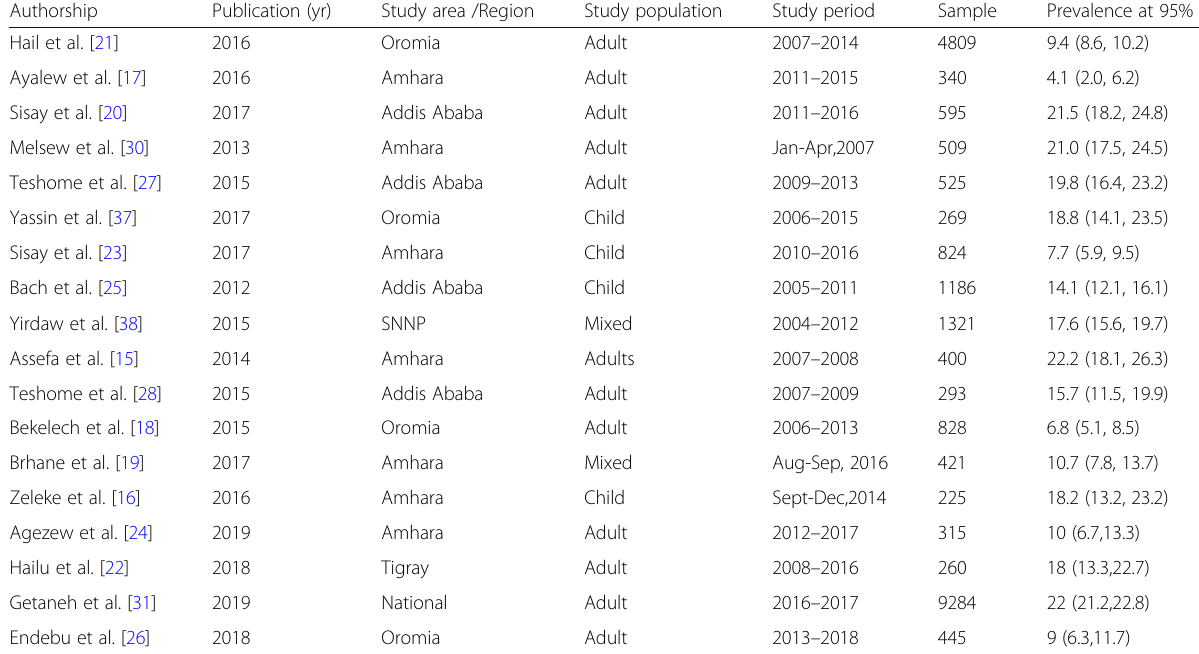
Table 1 Descriptive summary of 18 studies included in the meta-analysis of the prevalence first line treatment failure in Ethiopia